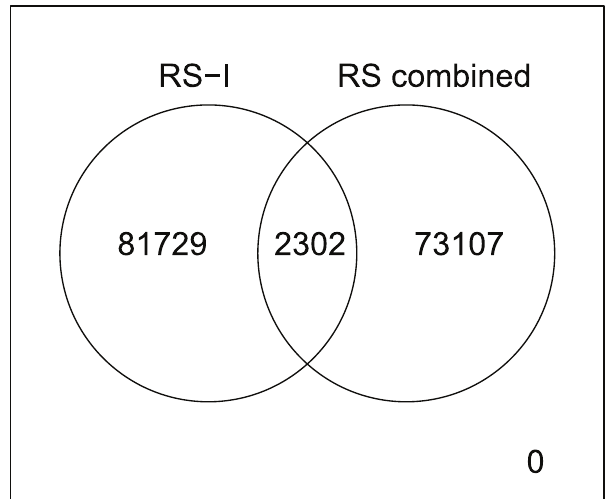
Figure 3. The smallest detectable effect with the current sample size of 2,996 individuals at 80% (a), 50% (b) and 1% (c) power levels.